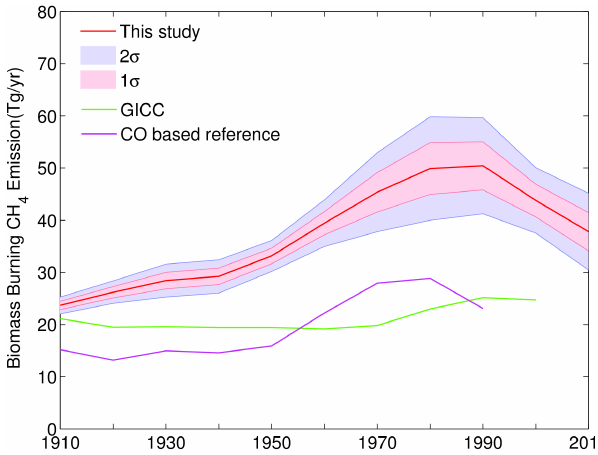
Figure A1. Sensitivity of estimated proposed biomass burning emissions with respect to varying δ 13 C (cid:49)E − 55 to −